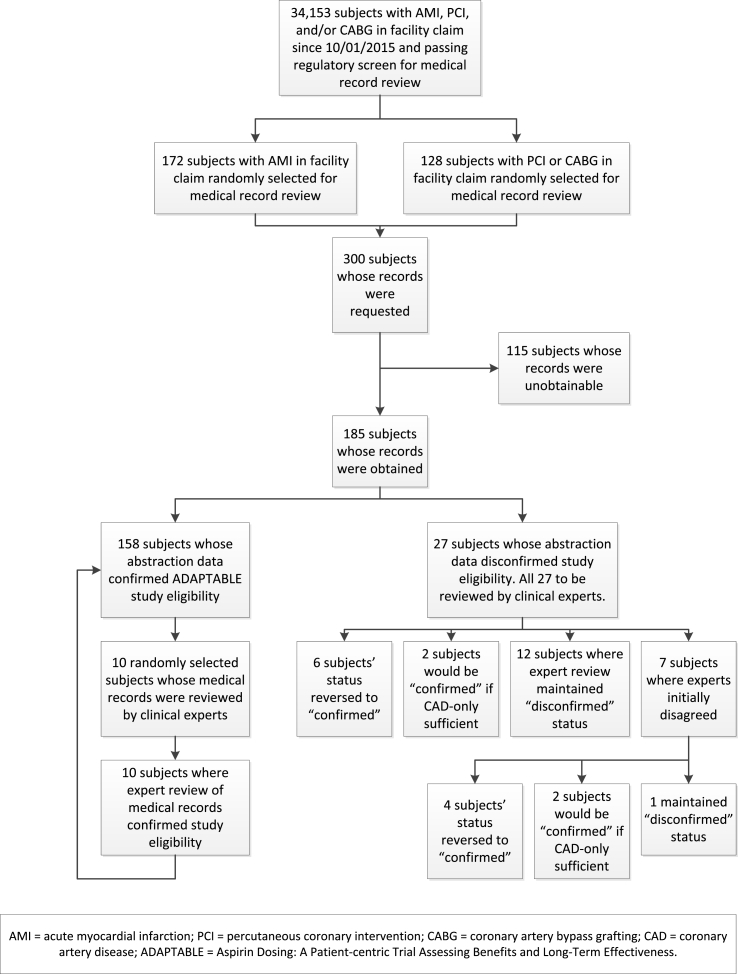
Study process flow.